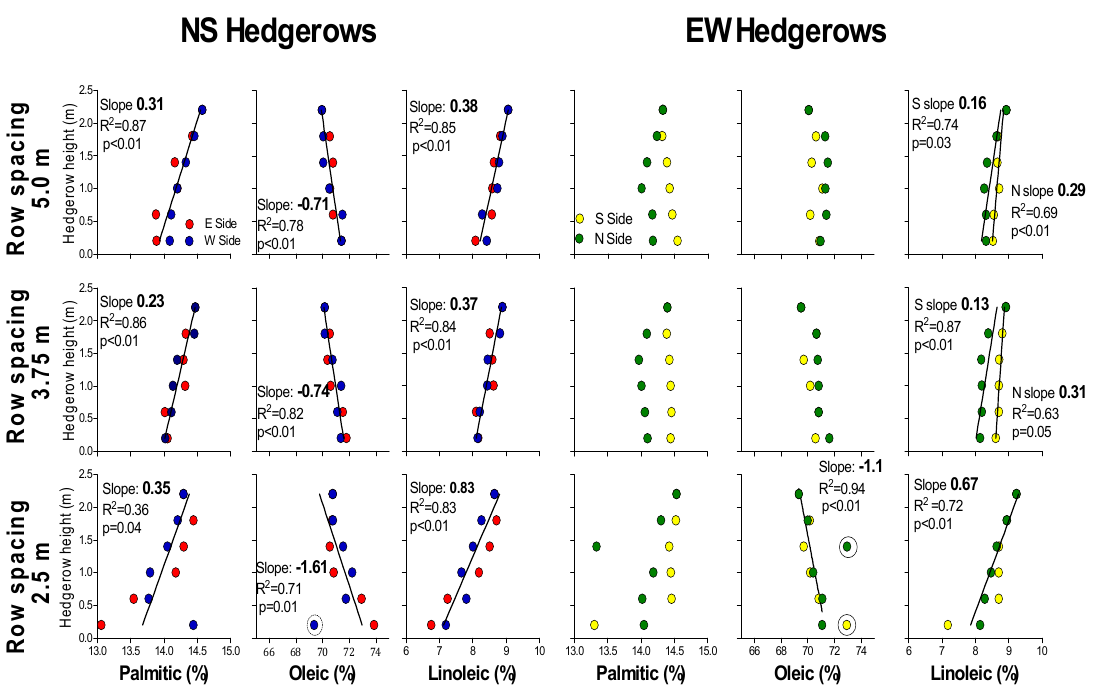
Figure 1. Major fatty acid contents of oils extracted from fruits harvested in vertical layers on E (red symbols) and W (blue symbols) sides of NS hedgerows and on S (yellow symbols) and N (green symbols) sides of EW hedgerows, both planted at three row spacings (5.0, 3.75 and 2.5 m). Each point is the average of two seasons (2012 and 2013). A single regression fitted to both sides of the hedgerow is shown when the individual coefficients of regression were not significantly different at p ≤ 0.05. Data inside the circles were not considered in the relationship. Regression lines to data from single or both sides of hedgerows are shown when significant. Data from NS hedgerows are adapted from Figure 3 in Trentacoste et al. [17]. 3.2. Response of Hedgerow Oil Yield and Quality to Spacing and Orientation Oil yield decreased with increasing row spacing (Figure 2). Production of 5-m spaced hedgerows decreased on average in 2012 and 2013 by 34% and 26% relative to the 2.5-m spacing in NS and EW hedgerows, respectively. There were no significant differences in oil produced within each orientation and year for hedgerows spaced at 5 or 3.75 m.